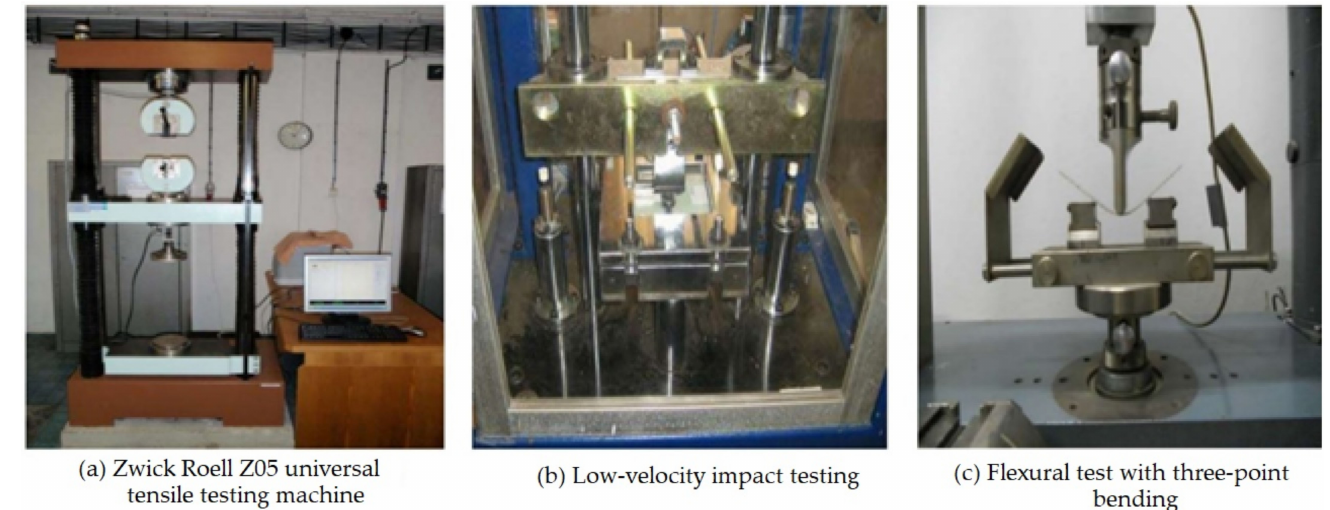
Figure 3. Mechanical testing of the composite